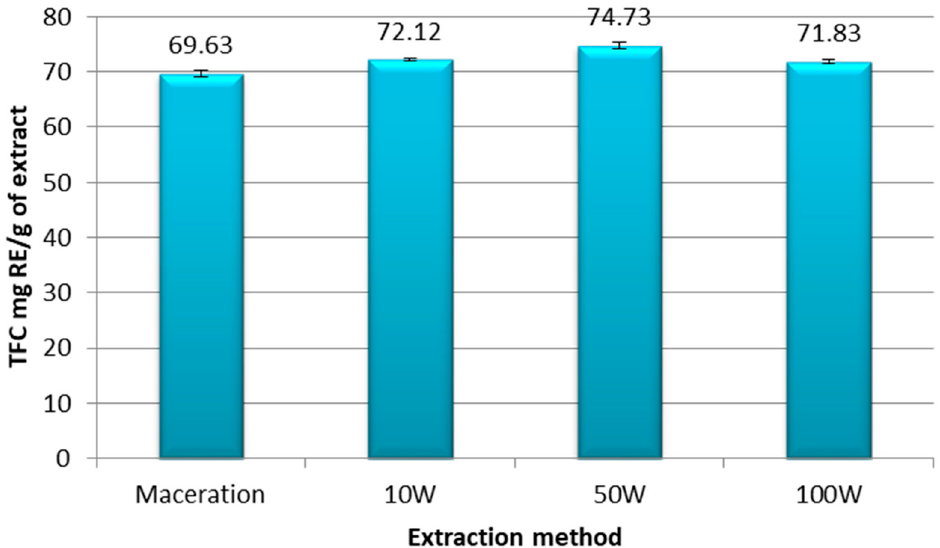
Figure 3. Total flavonoid compounds expressed in mg RE/g of extract of ethanolic extracts of pomegranate peel obtained by maceration and UAE at 10 W, 50 W, and 100 W. Experiments were repeated three times ( n = 3). Bars display mean ± S.D.